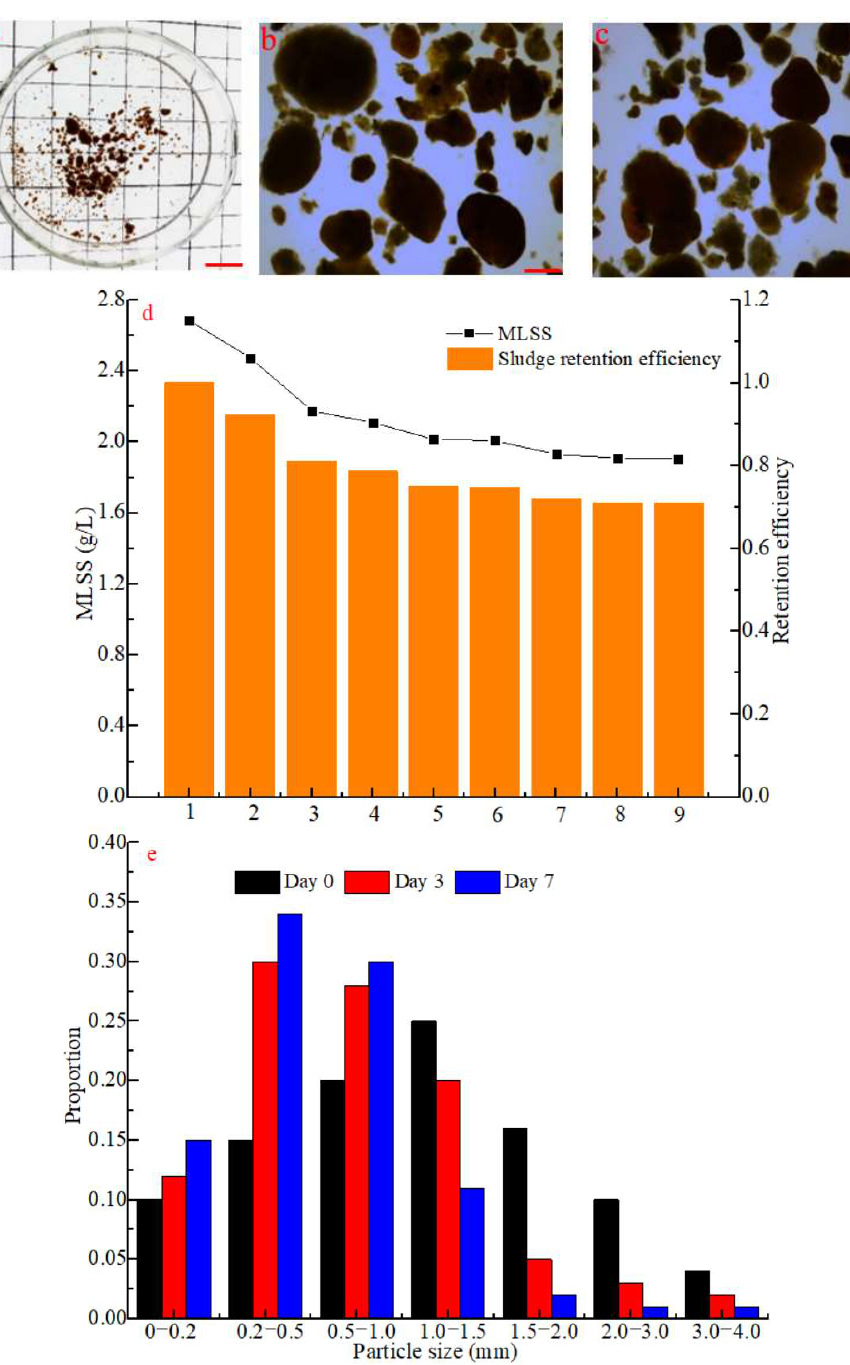
Figure 2. Effect of hydrodynamic force on sludge aggregates on ( a ) day 0, ( b ) day 3 and ( c ) day 7. ( d ) Sludge retention efficiency and concentration of suspended solids in the SBR as a function of the number of completed cycles. ( e ) Size distribution of aggregates within the first week post-conditioning; scale: 1 cm.